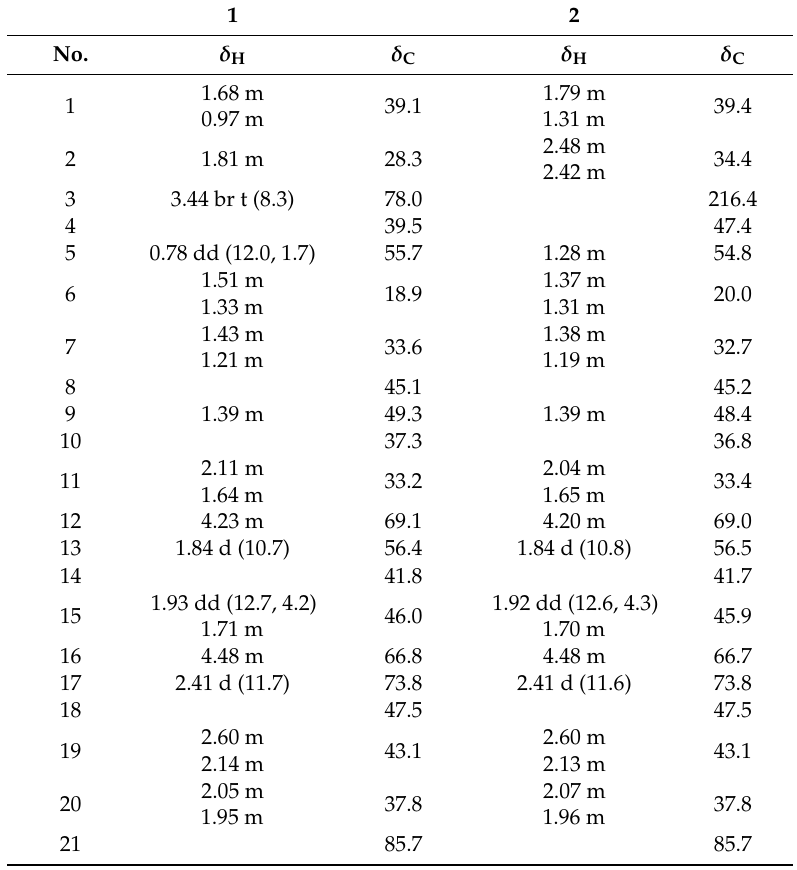
Table 1. 1 H (500 MHz) and 13 C (126 MHz) NMR data of 1 and 2 in Pyridine- d 5 ( δ in ppm, J in Hz).